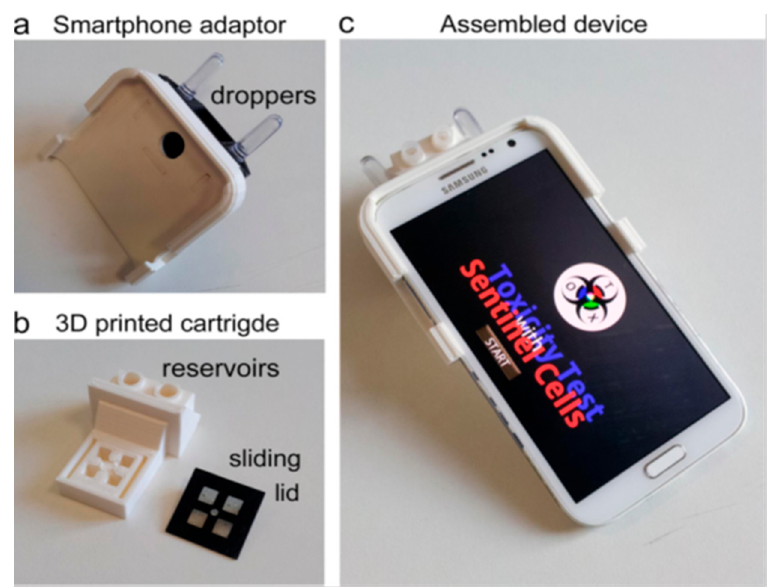
Figure 2. ( a ) A 3D printed smartphone adaptor depicting its ( b ) 3D printed cartridge being composed of reservoirs and sliding lid. ( c ) The assembled smartphone-based device for BL signal acquisition and analysis. Reproduced from Cevenini et al. [70].